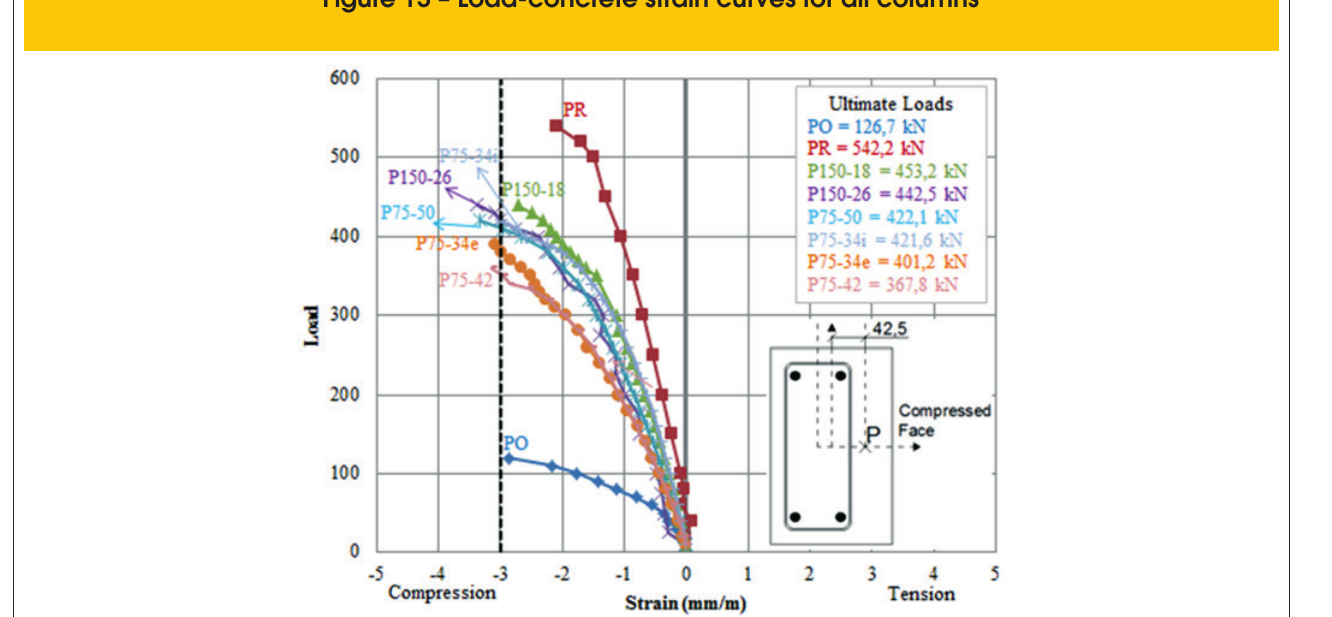
Figure 13 – Load-concrete strain curves for all